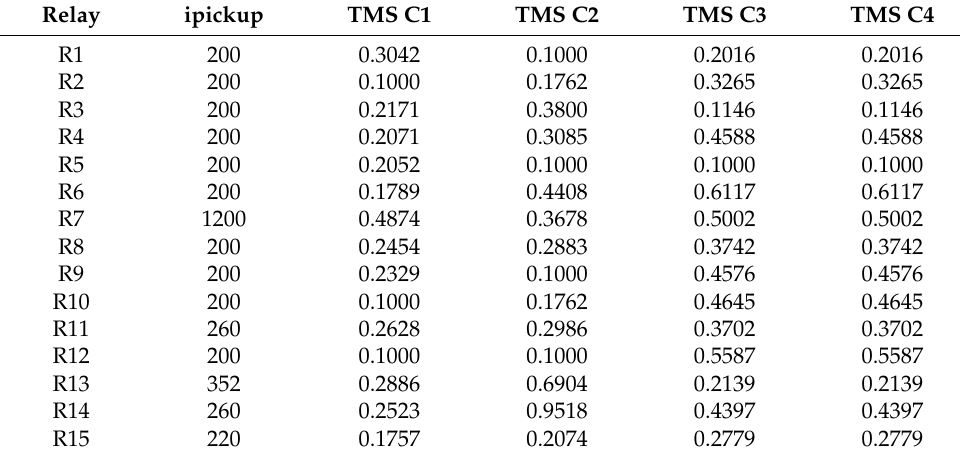
Table 7. Coordination adjustments with